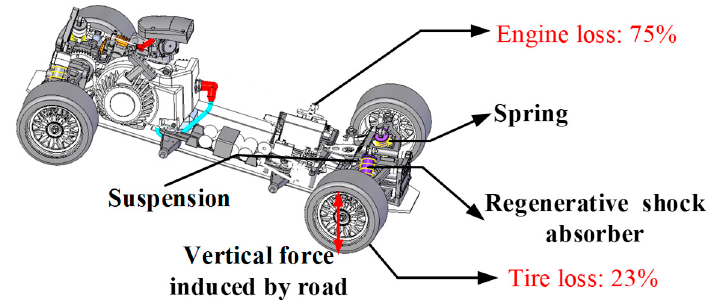
Figure 2. Vehicle energy consumption.